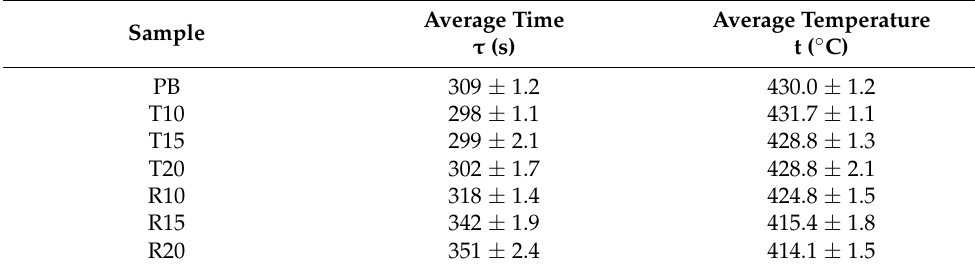
Table 3. Spontaneous ignition temperature of composite